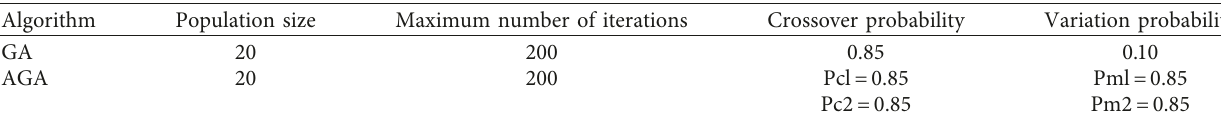
Table 6: Operating parameters.